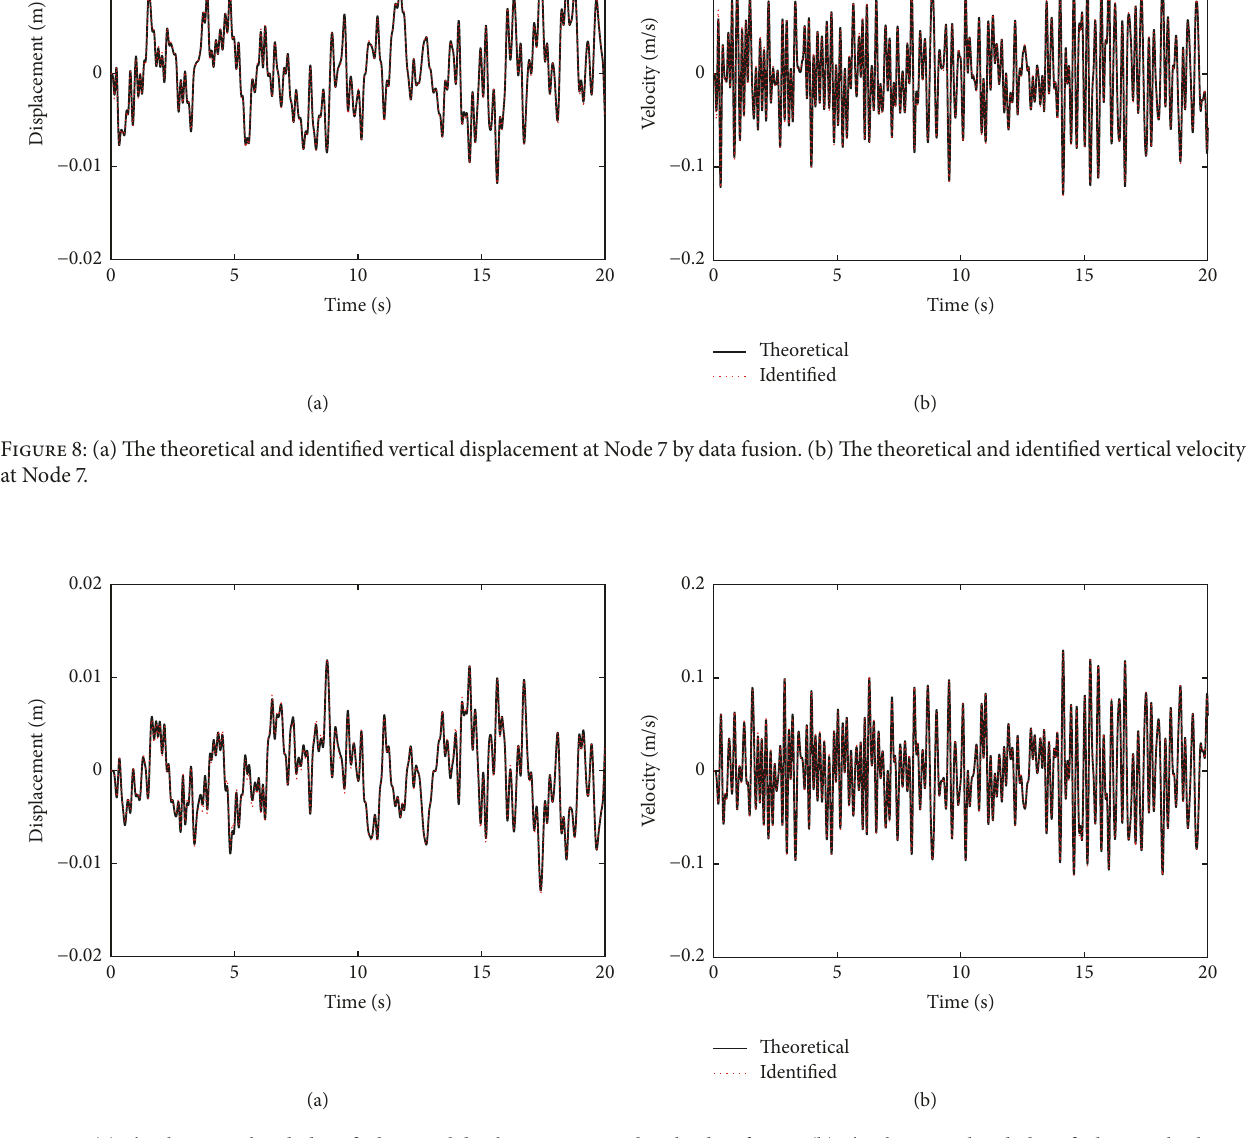
Figure 9: (a) The theoretical and identified vertical displacement at Node 11 by data fusion. (b) The theoretical and identified vertical velocity at Node 11.